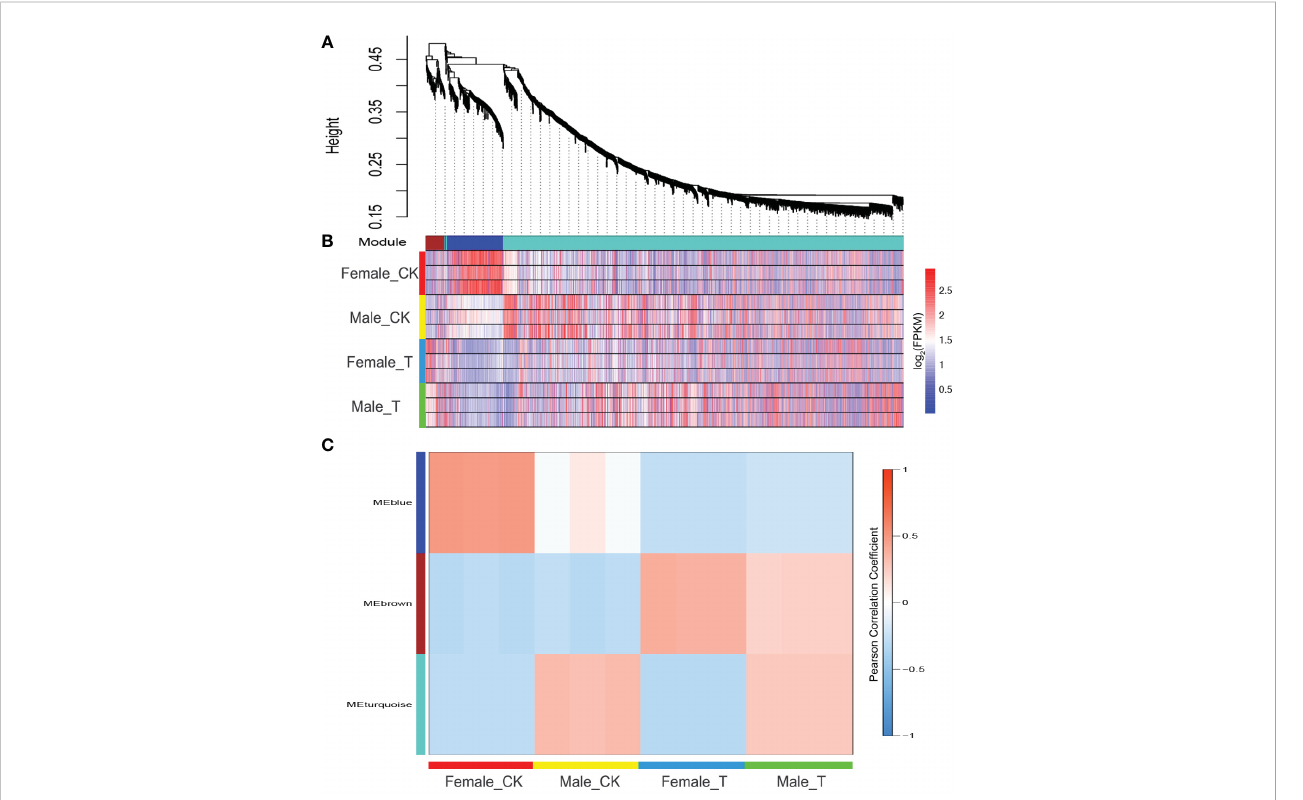
FIGURE 3 Weighted gene co-expression network analysis (WGCNA) of females and males response to salinity stress. (A) DEGs were classed into 3 modules. (B) The expression pro fi le of DEGs in 3 modules, Blue, reduced expression; red, increased expression. (C) Correlation analysis of 3 modules and Salix matsudana under different conditions.